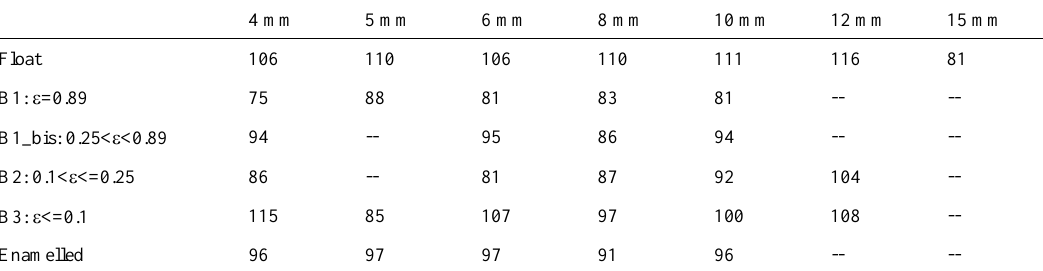
Table 6. Minimum value SC (MPa) vs conform FR for TT in SSV tested specimens